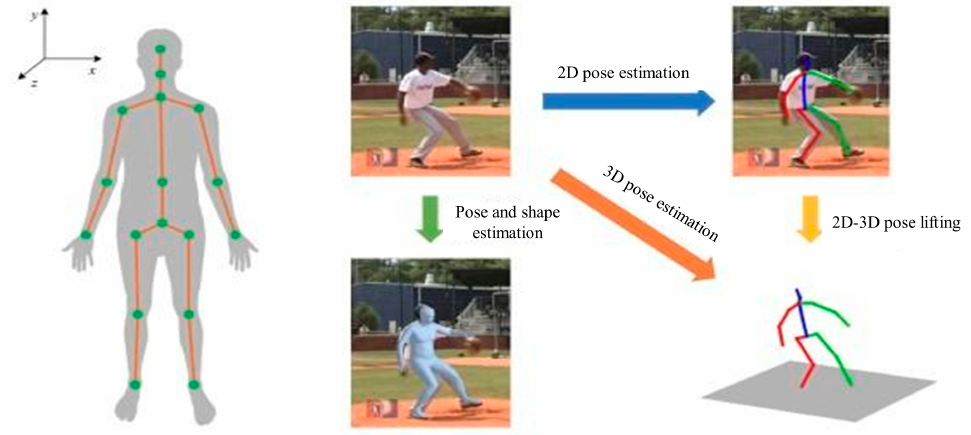
Figure 4. Establishing spatial